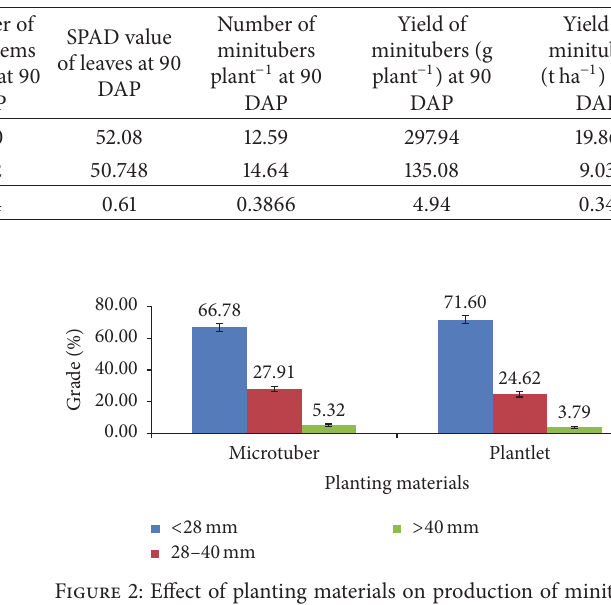
Table 2: Planting materials influencing potato production in field condition.